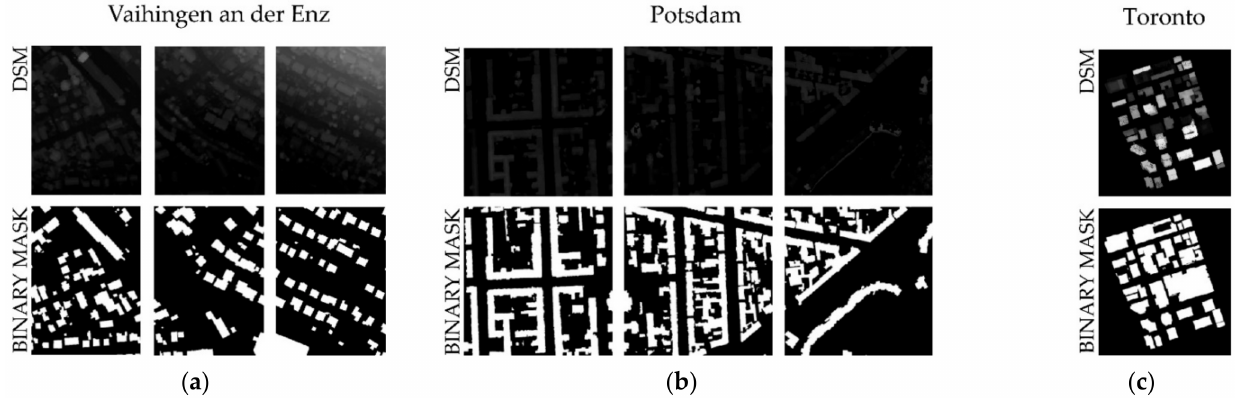
Figure 5. Sample of the dataset of digital surface model (DSM) patches and corresponding binary masks (ground truth): ( a ) Vaihingen test set, ( b ) Potsdam test set, and ( c ) Toronto test